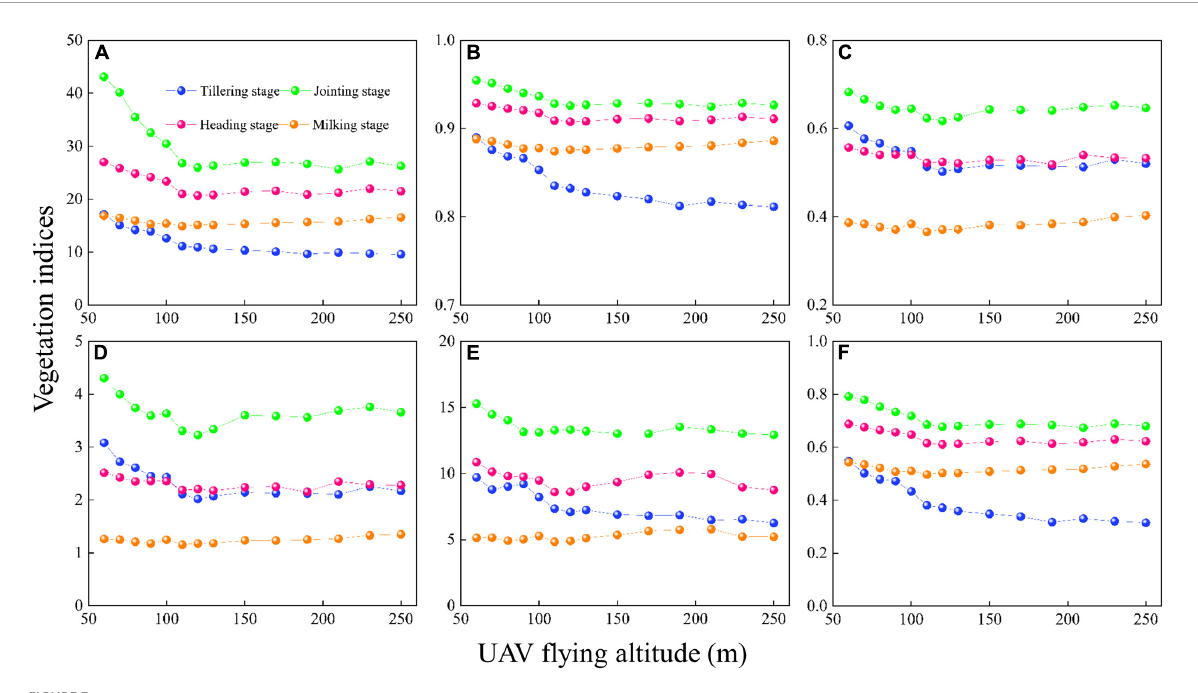
FIGURE3 Variation in VIs with different UAV-FAs: (A) RVI; (B) NDVI; (C) NDRE; (D) CI red edge ; (E) CI green ; and (F) WDRVI.